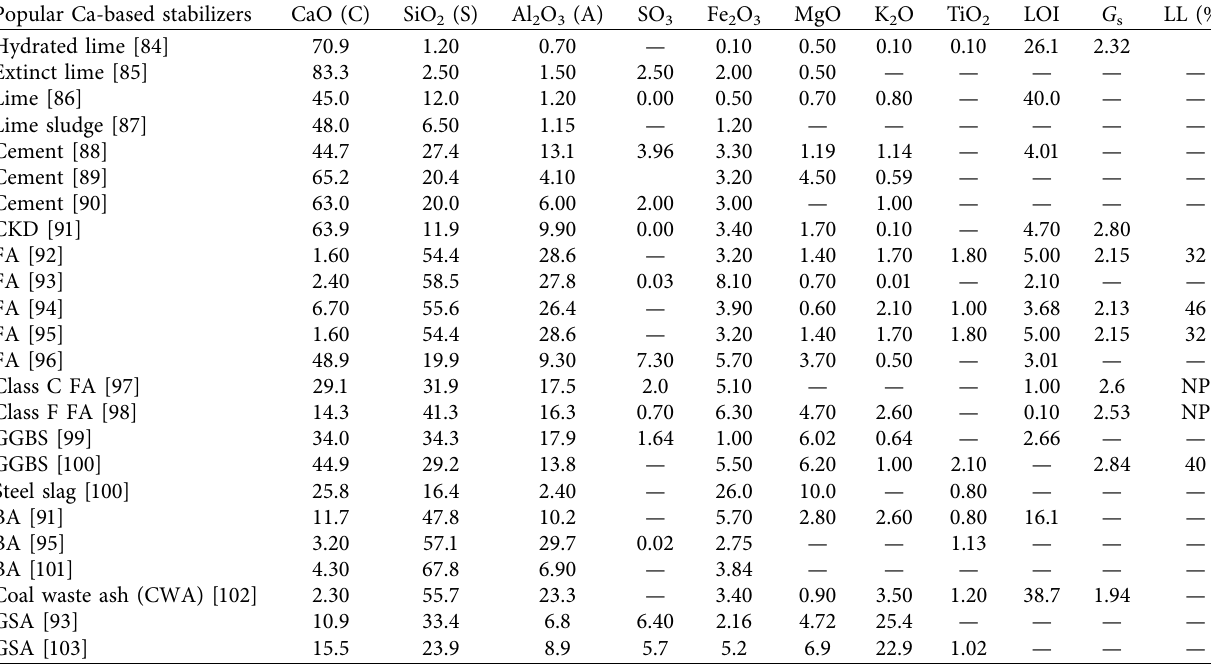
Table 3: Summary of oxide composition of traditional Ca-based stabilizer materials (CSMs) from previous studies. Popular Ca-based